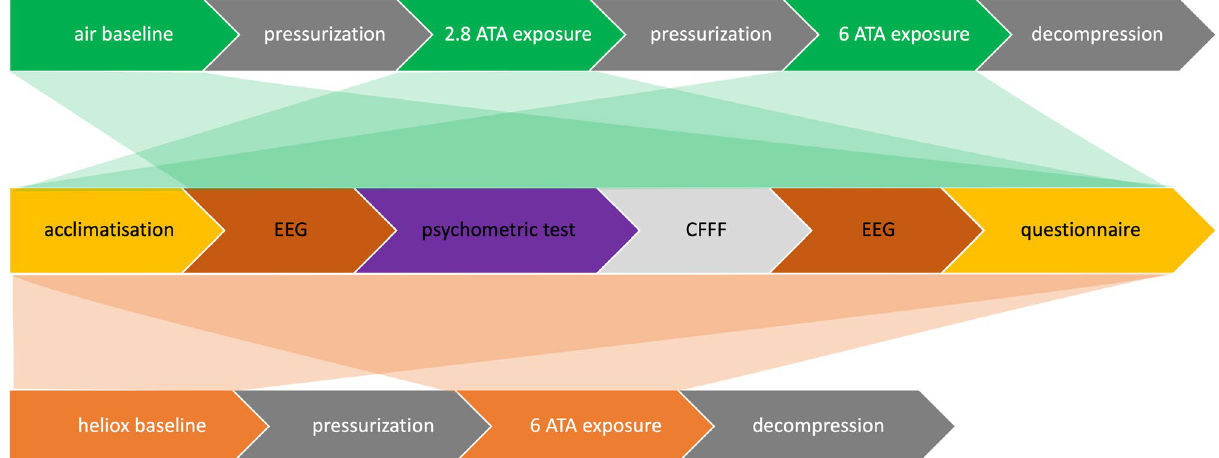
Figure 7. Air and heliox measurements. The top row describes the order of steps during the air measurement session. After preparation, a baseline measurement was conducted. Directly followed pressurization to 284 kPa, where the measurements were repeated. Further pressurization to 608 kPa was undertaken to repeat the measurements. The bottom row describes the heliox exposure, which involved measurements at the surface and 608 kPa. The middle row represents the recording order of the components in each measurement sequence after acclimatization. The air baseline measurement did not require an acclimatization